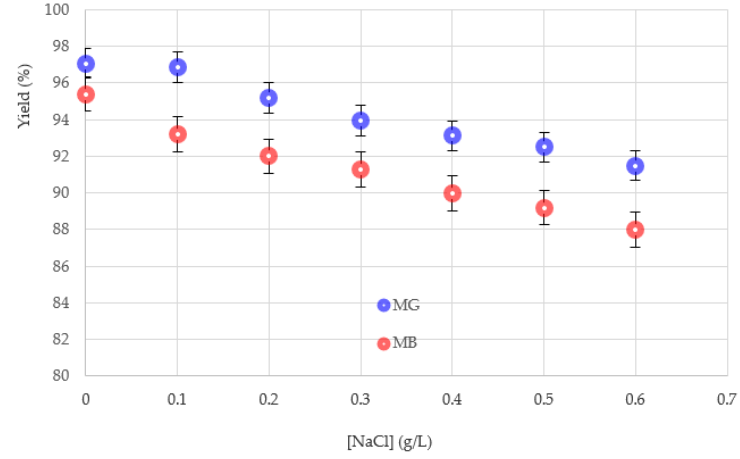
Figure 5. Effect of NaCl concentration on the adsorption percentage of MB and MG (C 0 (MB) = 8 mg/L, C 0 (MG) = 41 mg/L, S/L = 1 g/L, contact time 70 min, T = 25 ± 1 °C and unadjusted pH).